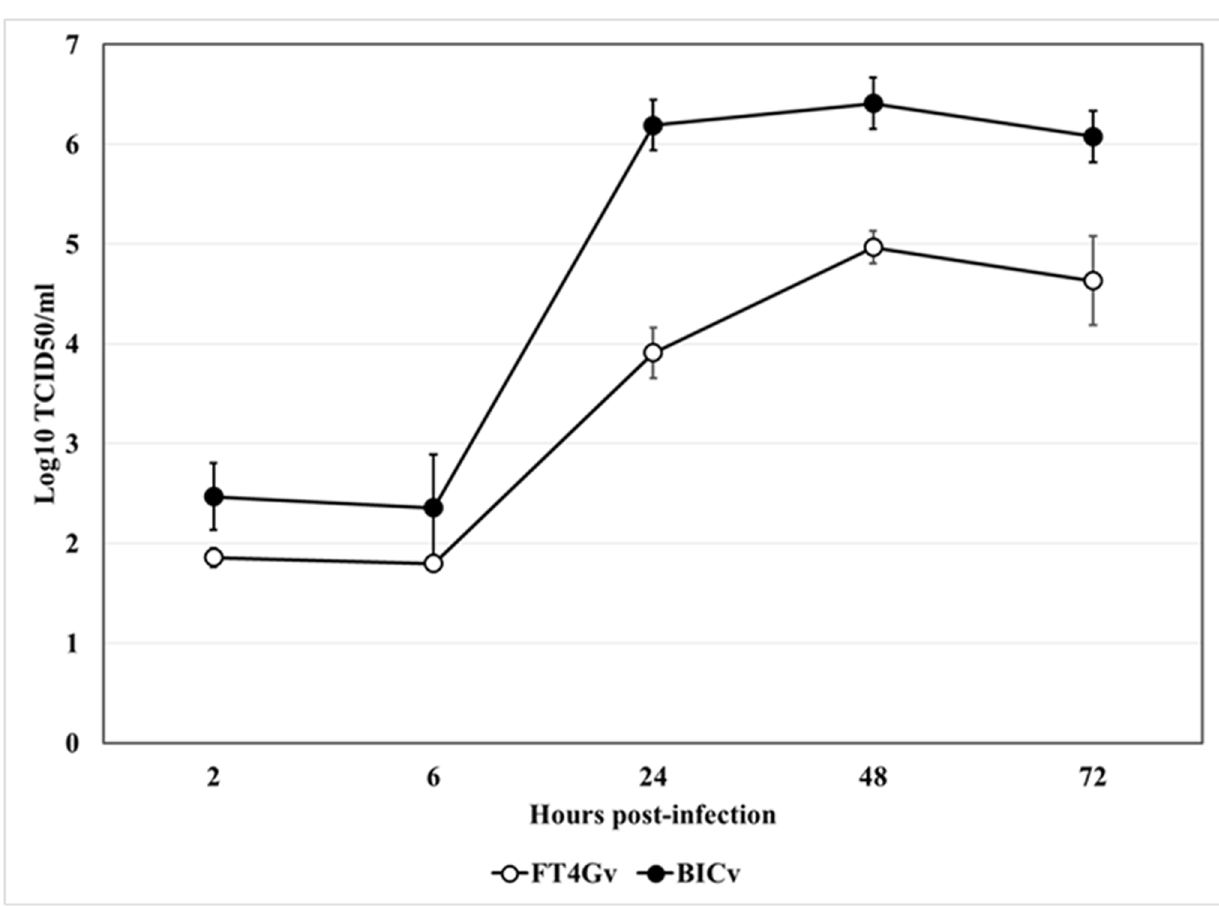
Fig 3. In vitro growth of FlagT4G virus. Primary cell cultures of swine macrophages were infected (MOI = 0.01) with FlagT4G or BIC viruses and virus yield titrated at the indicatedtimes post-infection in SK6 cells. Data represent means and standarddeviationsfrom two independent experiments. Sensitivity of virus detection: (cid:21) 1.8 TCID 50 /mL.